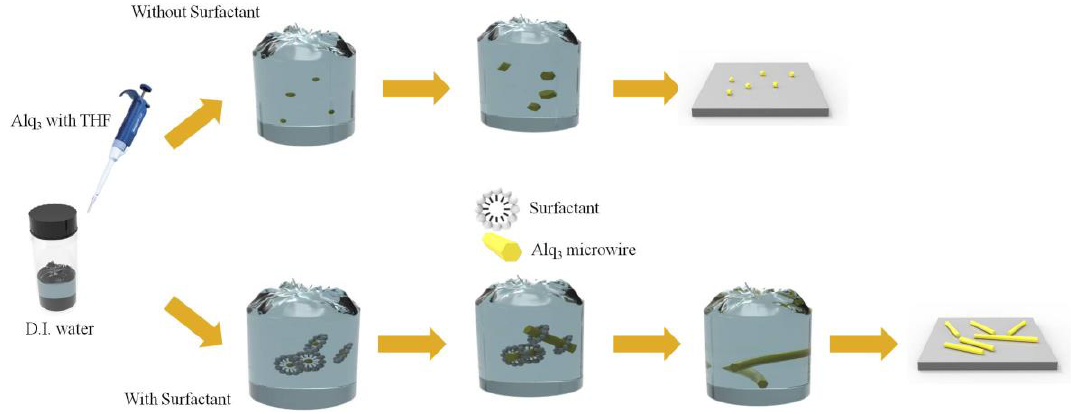
Figure 1. Schematic illustration of surfactant-assisted organic crystal growth using reprecipitation method.